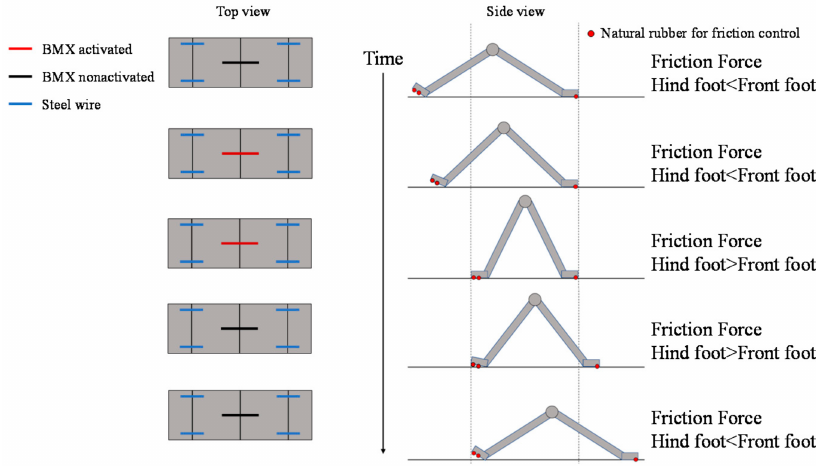
Figure 15. Walking mechanism of the origami